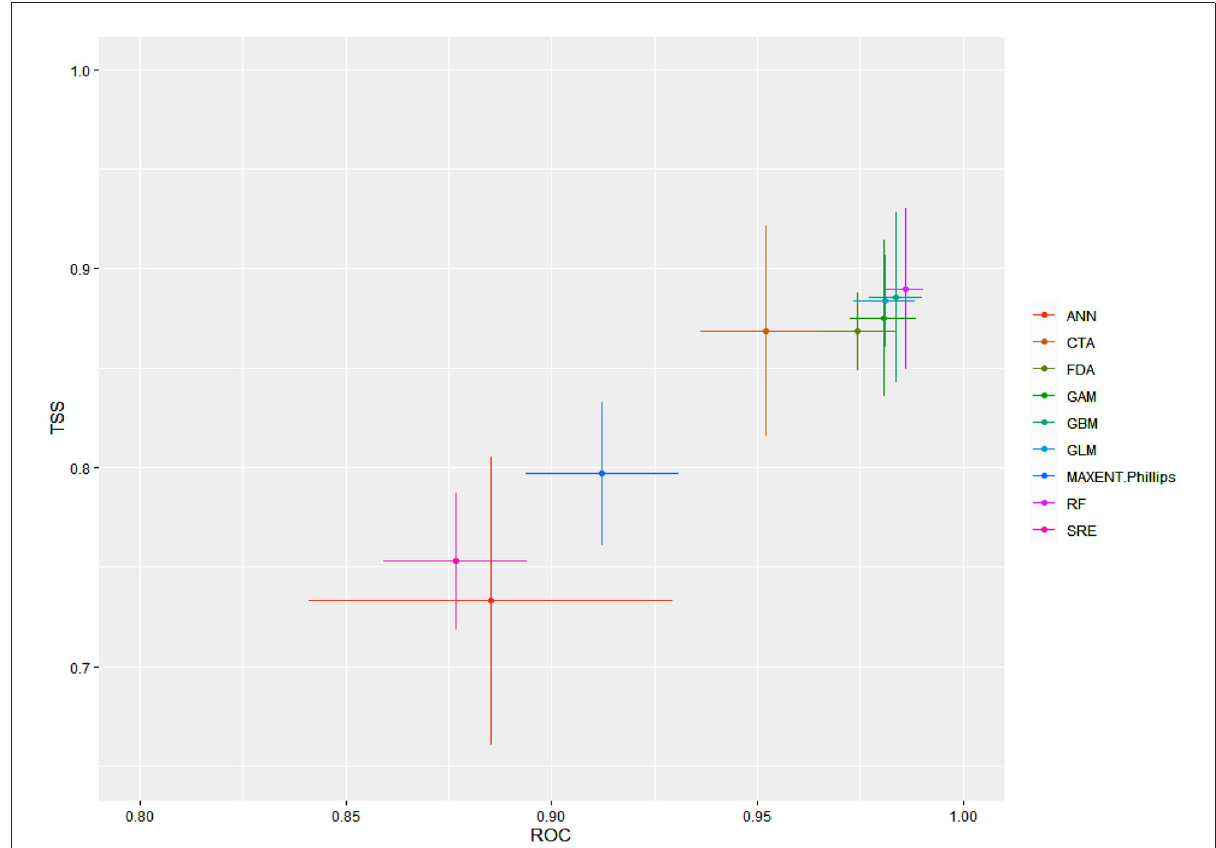
FIGURE1 For Olea europaea subsp. cuspidata , mean model evaluation scores by algorithms according to two separate evaluation metrics, ROC (AUC) and TSS.